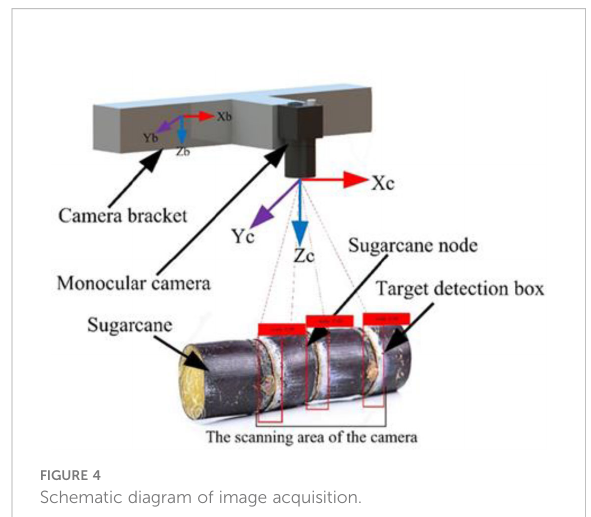
FIGURE 4 Schematic diagram of image